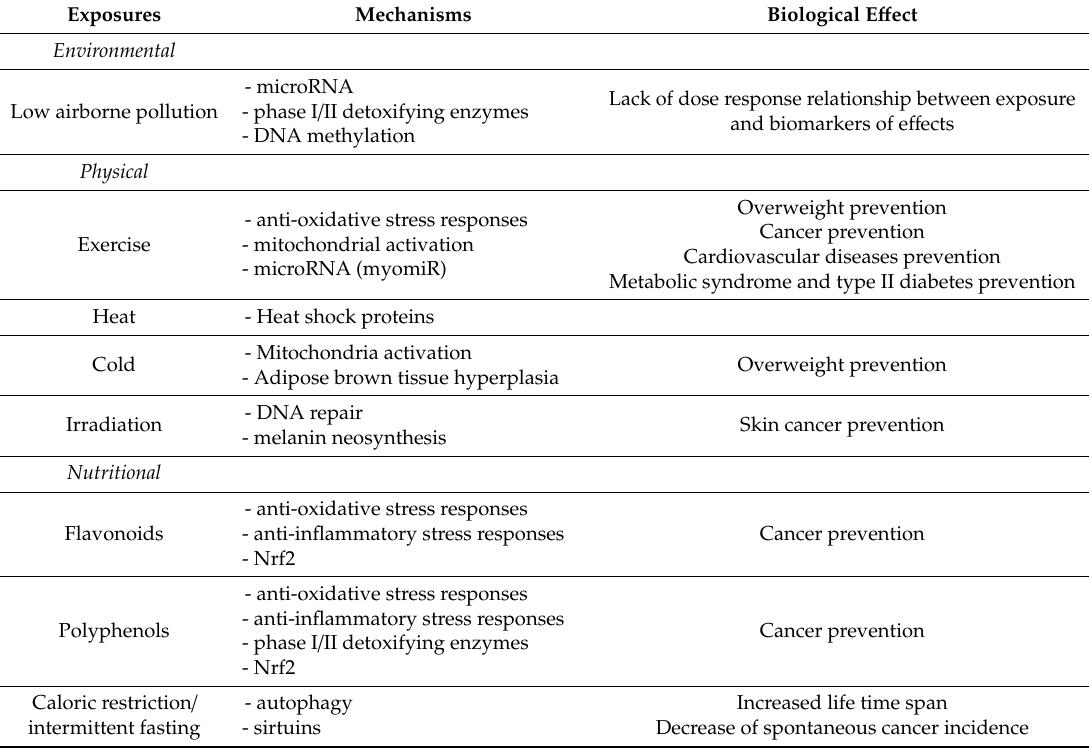
Table 1. Hormesis: Practical examples and triggered